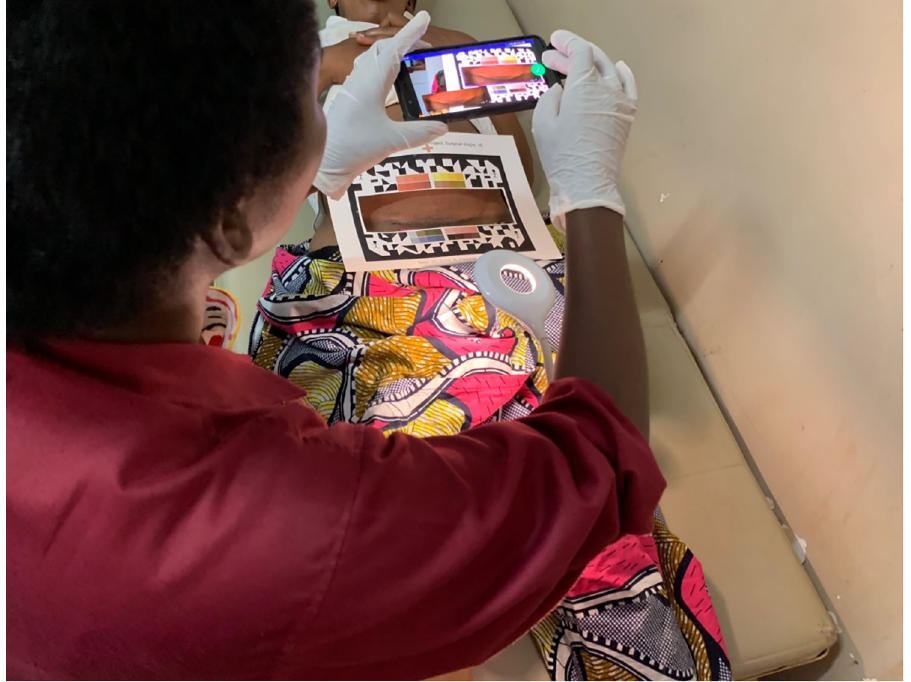
Fig 1. Health provider using the WoundScreener